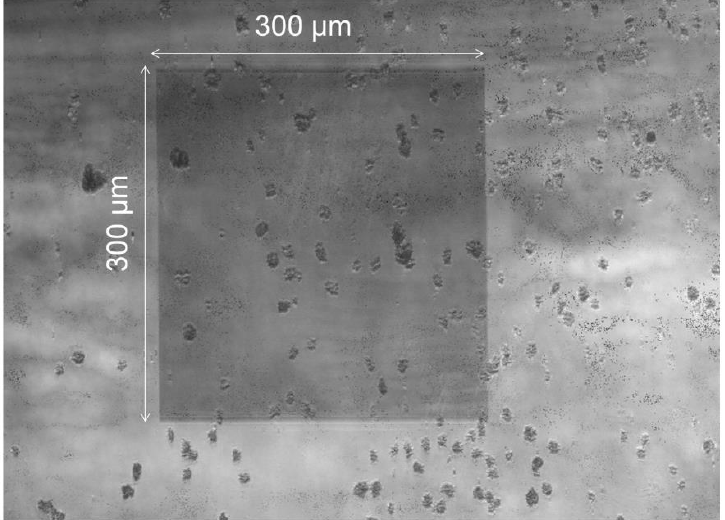
Figure 6. A suspension of 100 cells in 1 mL culture medium was introduced to the funnel chip integrated with the sandwich-magnet-with-a-tip configuration and flow rate of 300 µL·min −1 . Approximately 40% of the cancer cells were captured on the detection